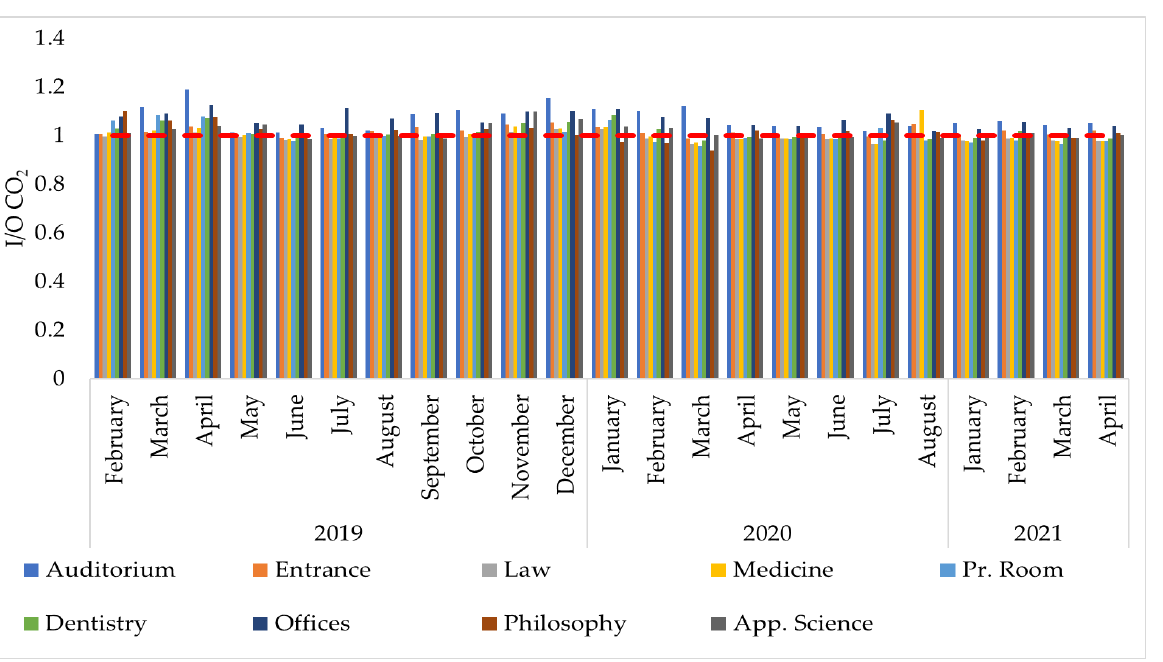
Figure 11. Indoor to outdoor (I/O) ratio of TVOC levels within the museum during the entire experimental period. 3.3. COVID-19 Restriction Impact The impact of the COVID-19 pandemic on the building’s behavior is profound in terms of both the CO 2 levels as well as the TVOC, as can be seen in Tables 3 and 4. The TVOC concentration, representing the usage of cleaning materials such as detergents and antiseptic hand gels, was higher in both years compared to 2019 levels in almost all areas. The areas that present higher increases are the Auditorium and the exhibition rooms on the 2nd floor, while regarding the whole building, TVOC concentration doubled in 2021 compared to 2019.